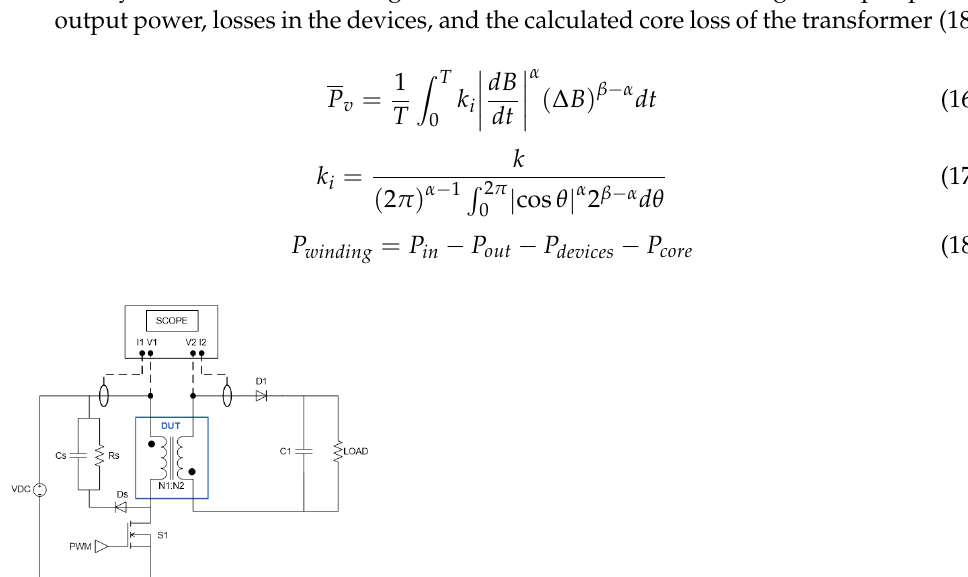
Table 2. Characteristics of the measured transformers.